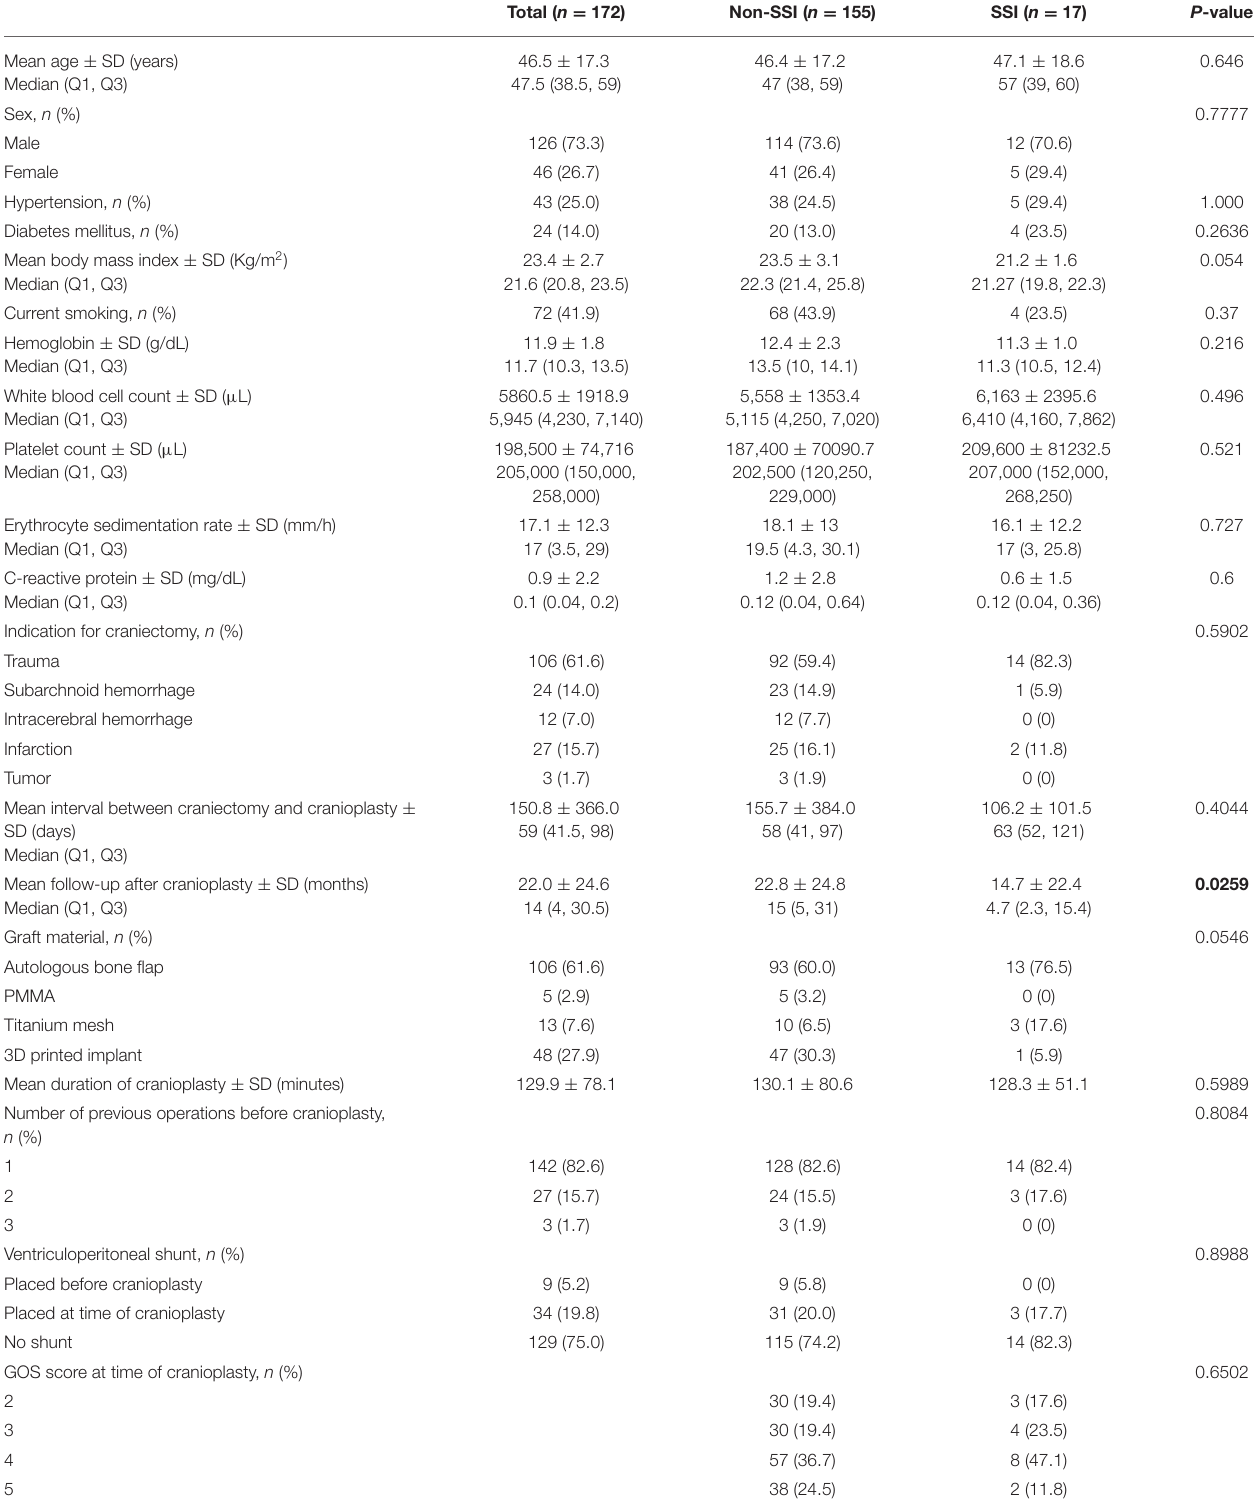
TABLE 1 | Comparative baseline characteristics, patients-, and surgery-specific factors of all patients in the non-SSI and SSI following cranioplasty cohorts. Total ( n = 172) Non-SSI ( n = 155) SSI ( n = 17) P